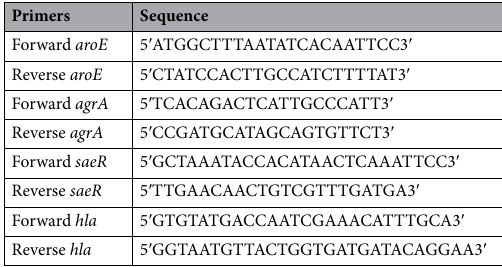
Table 1. Primer sequences of genes amplified in